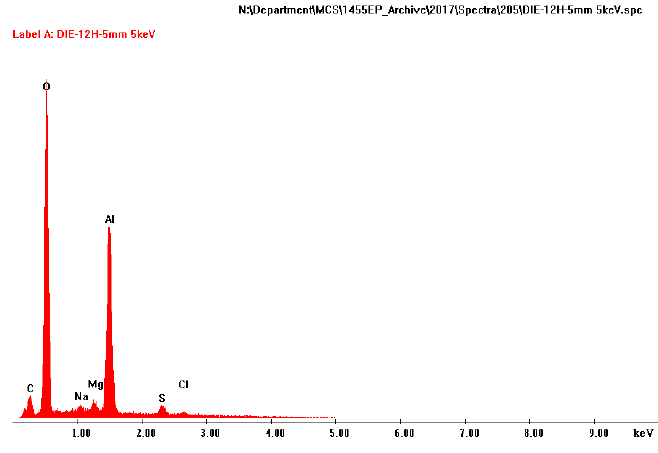
Figure 6. EDX analysis of the deposit found on the surface of TSA.